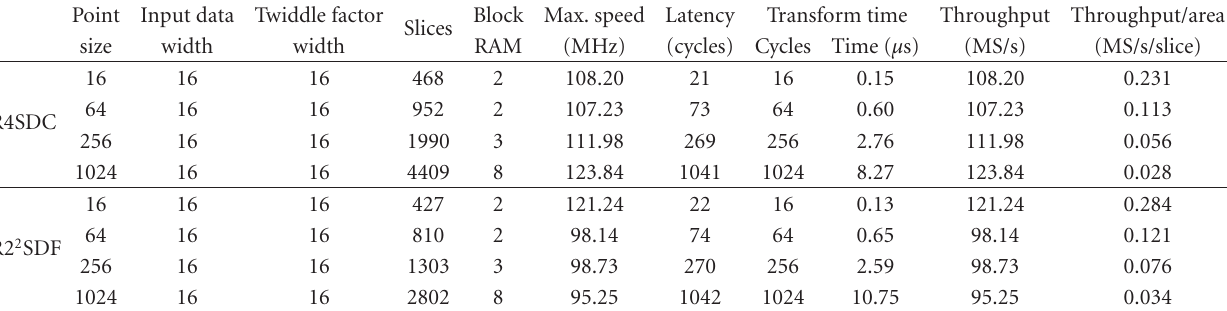
Table 4: Implementation results on Spartan-3 devices.